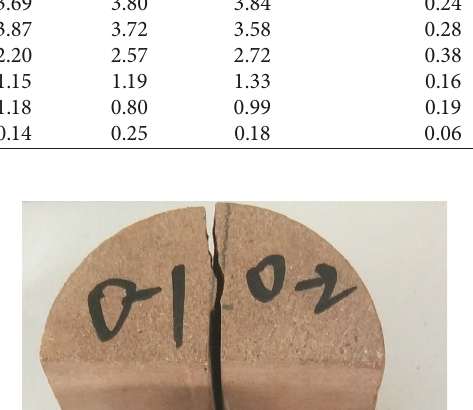
Figure 6: Fracture trajectory of red sandstone at 700 ° C.